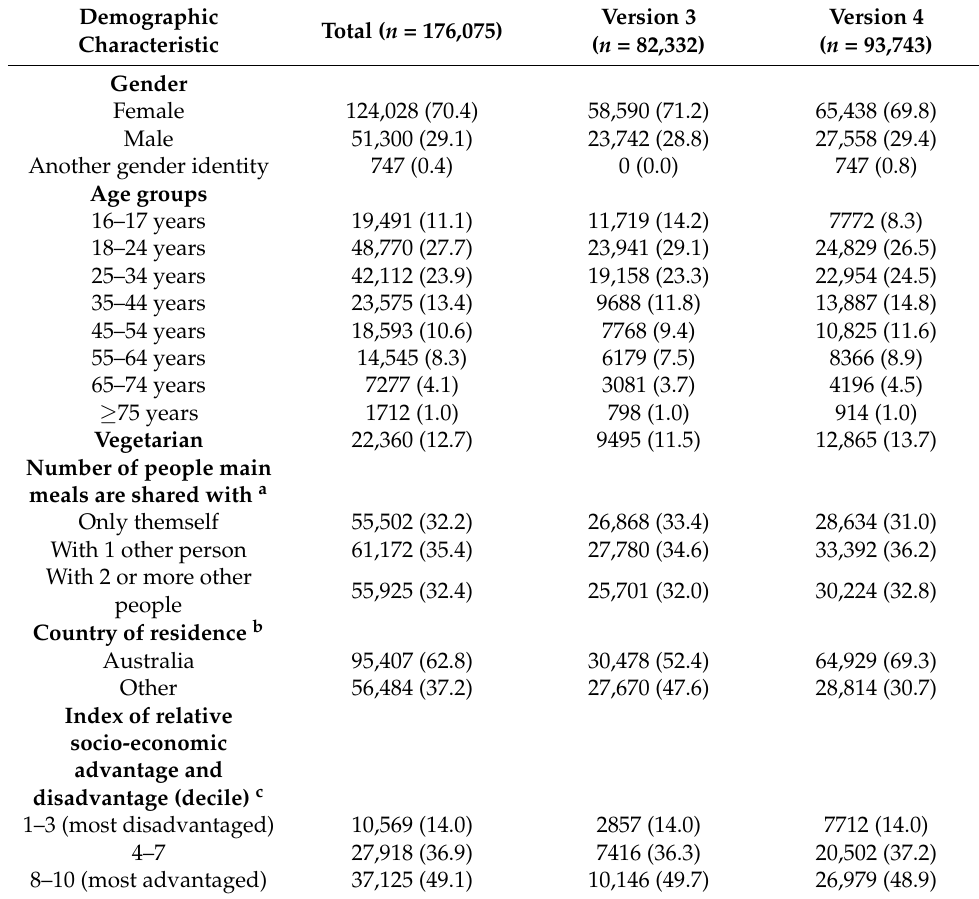
Table 1. Demographics of adults who completed the Healthy Eating Quiz and met study inclusion criteria from 2016–2022 ( n =